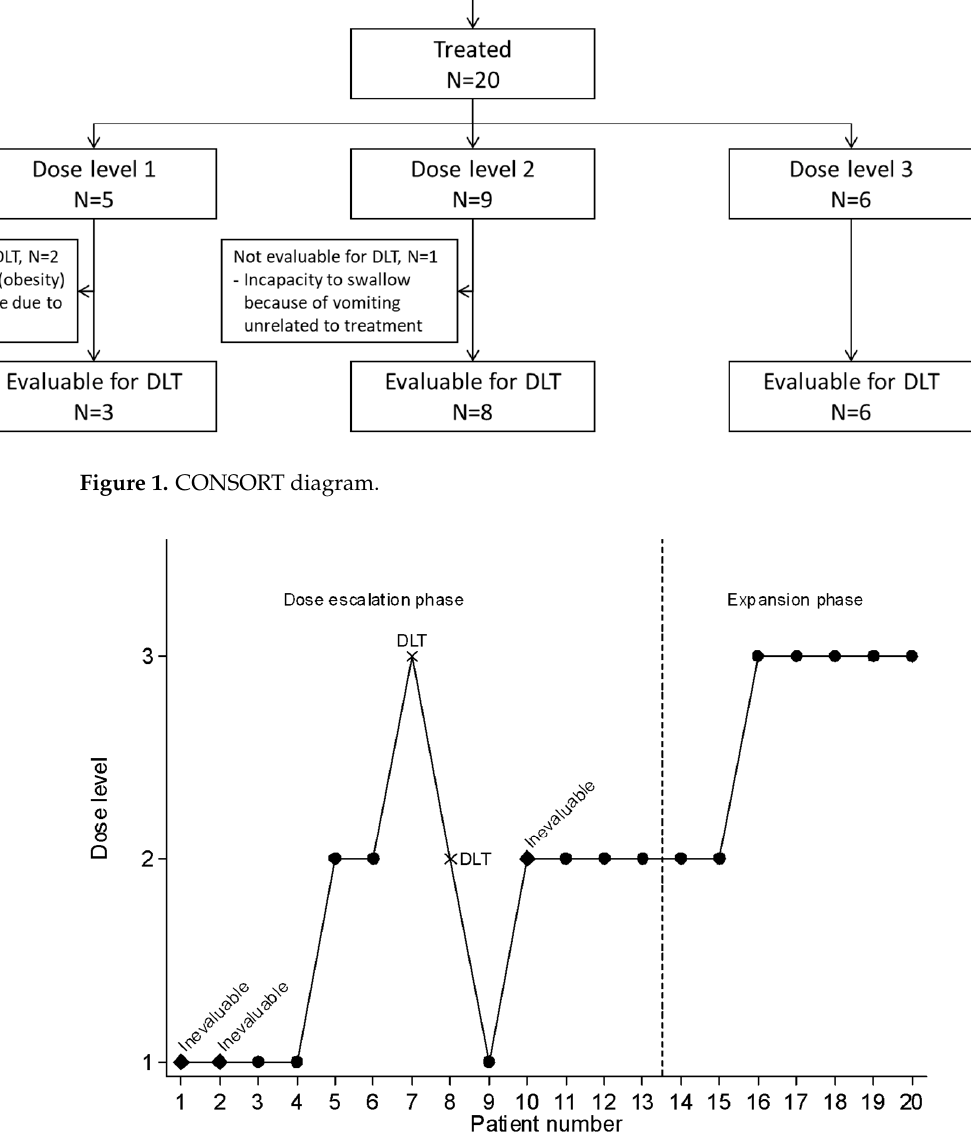
Figure 2. Sequential inclusion of patients with the allocated dose level. Table 1. Characteristics of the 20 patients.